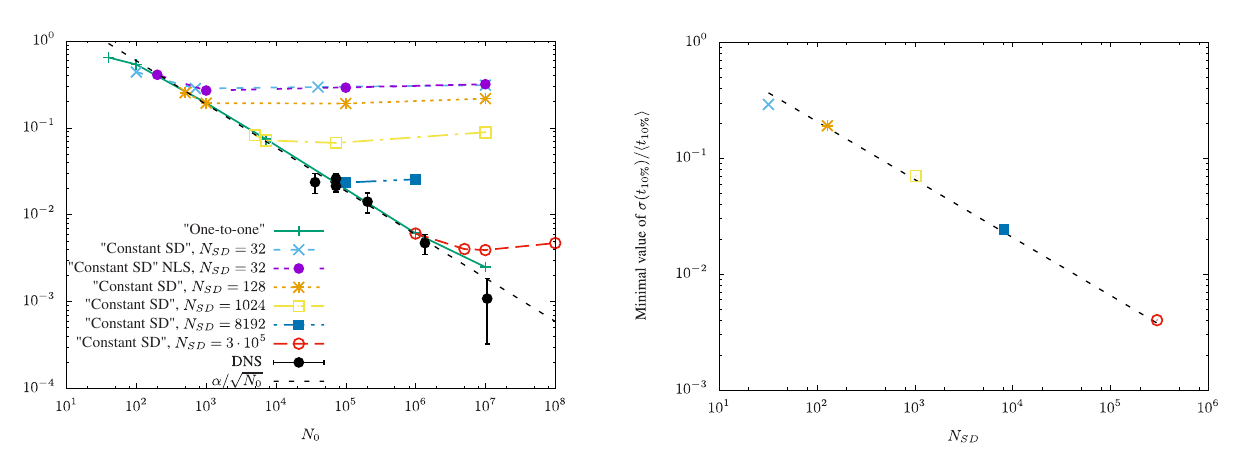
Figure 6. Points depict the minimal, limiting value of the relative standard deviation of t 10% for a given number of super-droplets in “constant SD” simulations. For each value of N SD , the minimal value of σ(t 10% )/ (cid:104) t 10% (cid:105) is calculated as an average of the respec- √ N 0 curve in Fig. 5. The line depicts tive points to the right of the α/ √ N SD with β = the fitted function β/